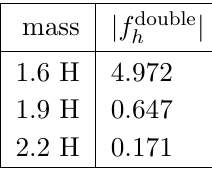
Figure 9 . Dimensionless three-point function F double E(cid:11)ective description (B.31) with (cid:21) 2 = 0 : 2; (cid:21) h = 0 : 5.